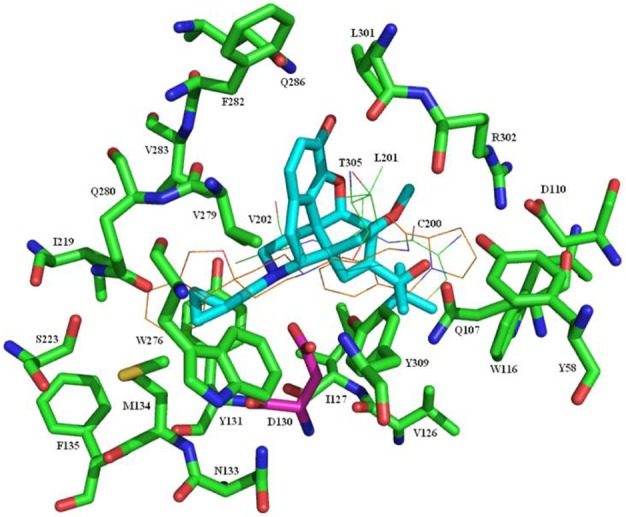
Docking of Buprenorphine (1) in the binding site of the NOP receptor. 1 is shown with cyan carbons. The protein is shown with green carbons apart from D130 which has purple carbons. For clarity, residues C200, L201, V202, and T305 are shown as lines rather than sticks. The crystal structure ligand, C-24, is shown as lines with brown carbons.